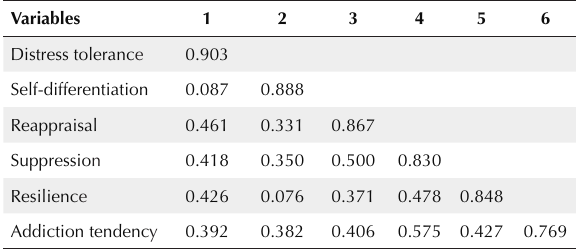
Table 3. Correlation matrix among the research variables